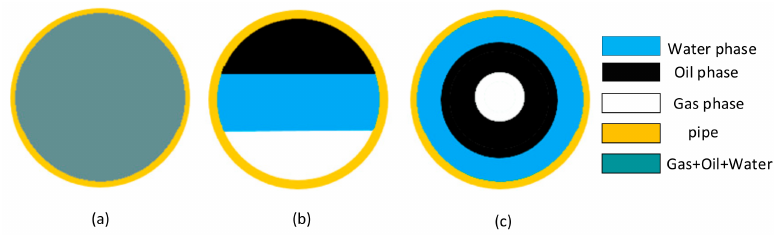
Figure 2. Simulated flow regimes: ( a ) homogenous ( b ) stratified ( c )